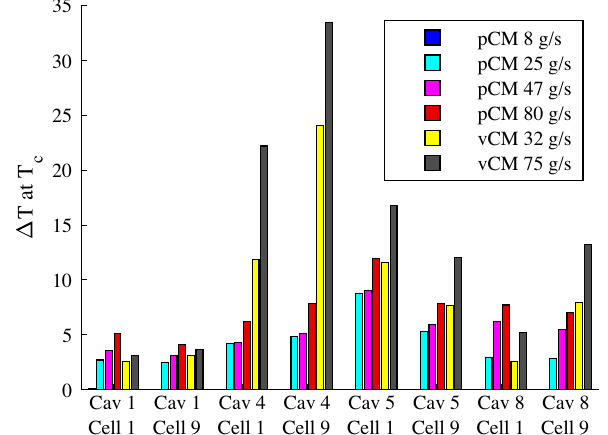
FIG. 16. Top to bottom cavity temperature difference at the critical temperature during cooldown. Having a high Δ T is important to achieve strong flux expulsion.